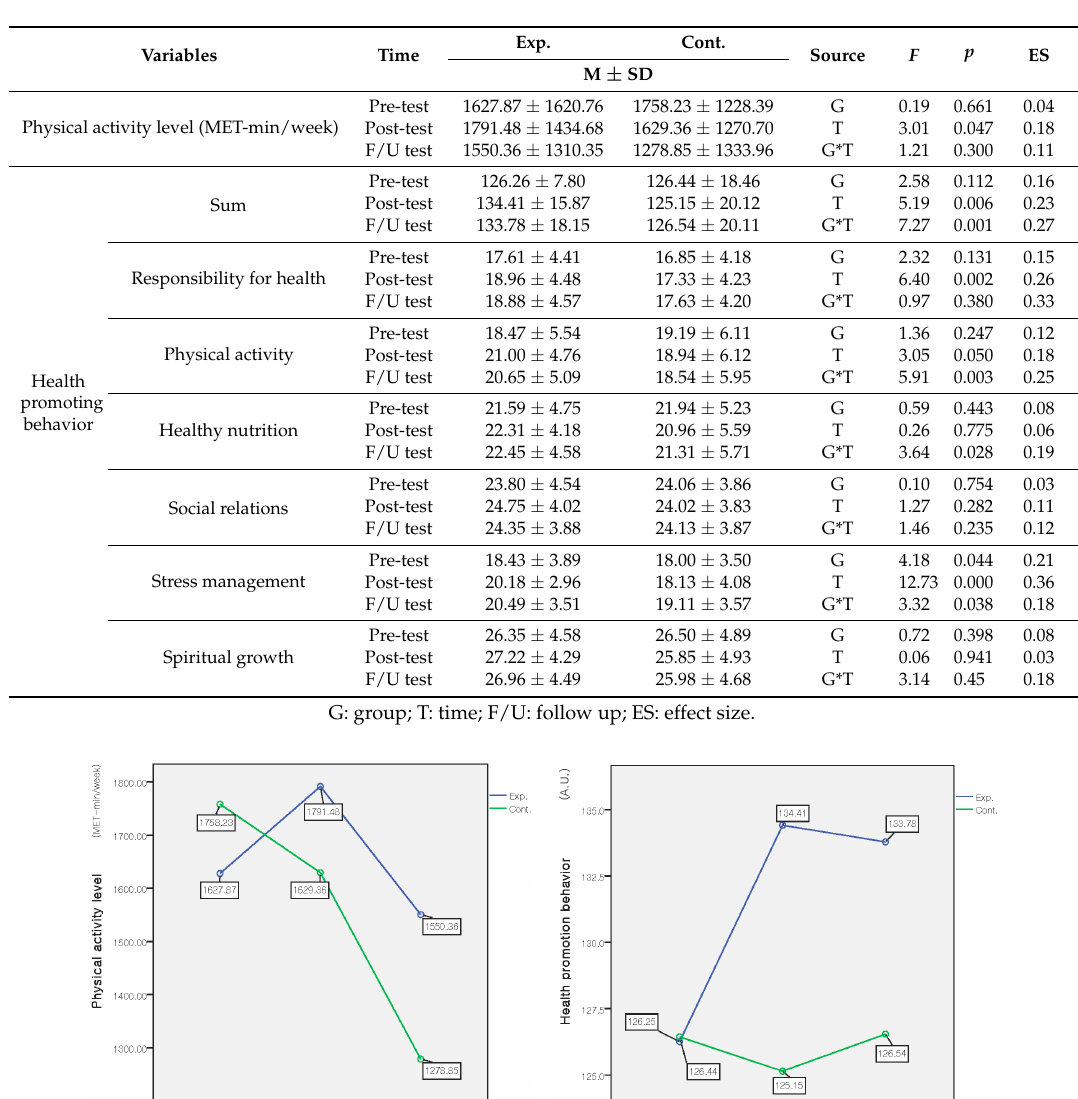
Table 2. Group comparisons of health promotion behavior and physical activity at pre-, post-, and follow-up test.